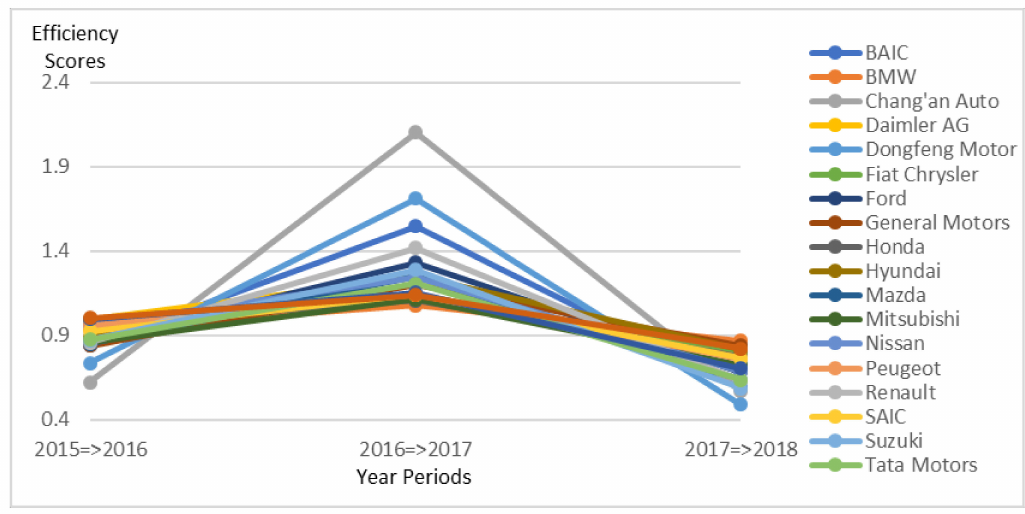
Figure 8. Technical-e ffi ciency frontier of the